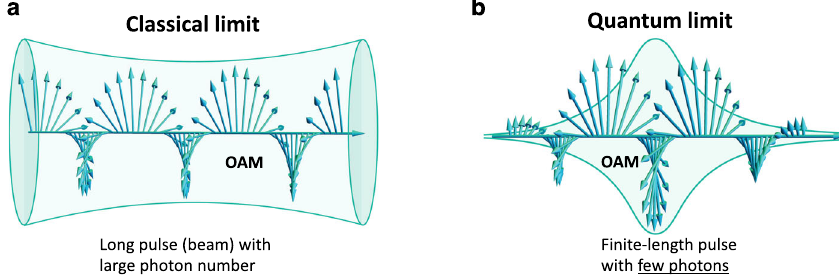
Fig. 1 Contrast between a traditional twisted beam and quantum pulse. Schematic of a traditional twisted beam a compared to the quantum twisted pulse b put forth in this paper. The semi-classical theory only captures the mean orbital angular momentum (OAM) of a laser beam with large photon number. However, the quantum effects of photon statistics, vectorial uncertainty relations, and non-local spin noise require a quantum-theoretical framework put forth in this